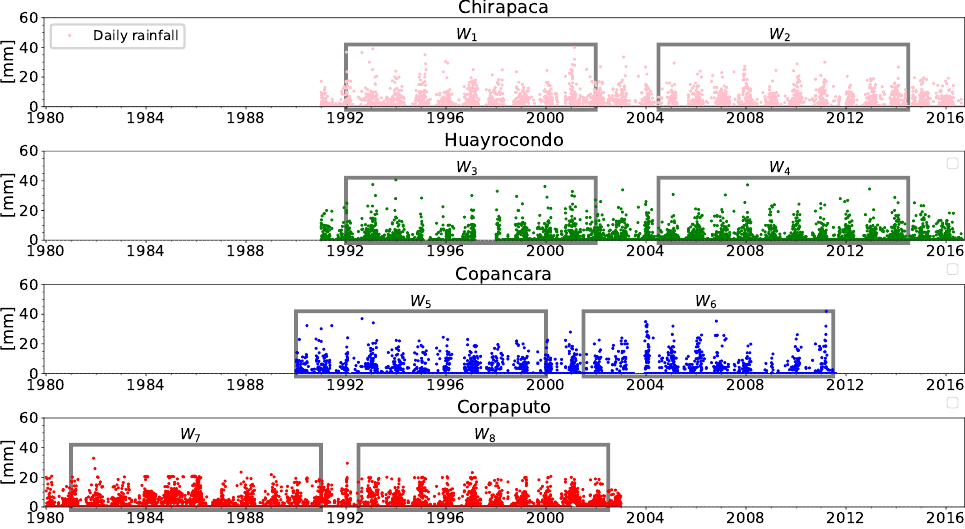
Figure 3. Time series of rainfall from the closest weather stations to greenhouses (Figure 1): Chirapaca (pink circle), Huayrocondo (green circle), Copancara (blue circle), and Corpaputo (red circle). For each time series, we have chosen two time windows that span 10 years and do not overlap with each other (rectangles, named as W i , i = 1 . . . 8). Note that one window starts in summer and another one in winter (Table 2). Table 2. Main characteristics of rainfall for selected time windows ( W 1 , . . . , W 8 ). There are two windows that span 10 years for each rain gauge, one beginning in austral summer and another one in winter, respectively. Maximum daily rainfall, the total 10-year accumulated rainfall, and the percentage of rainy days are included for each time